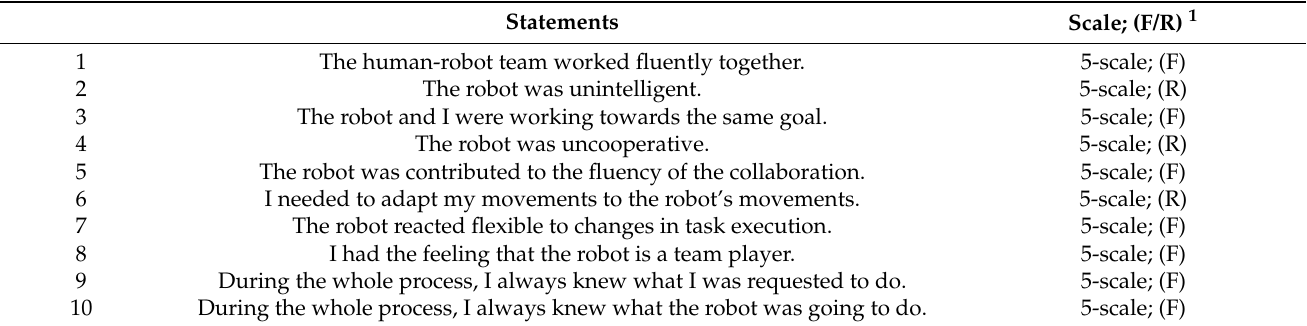
Table A2. Fluency questionnaire (extended and adapted based on [54]).